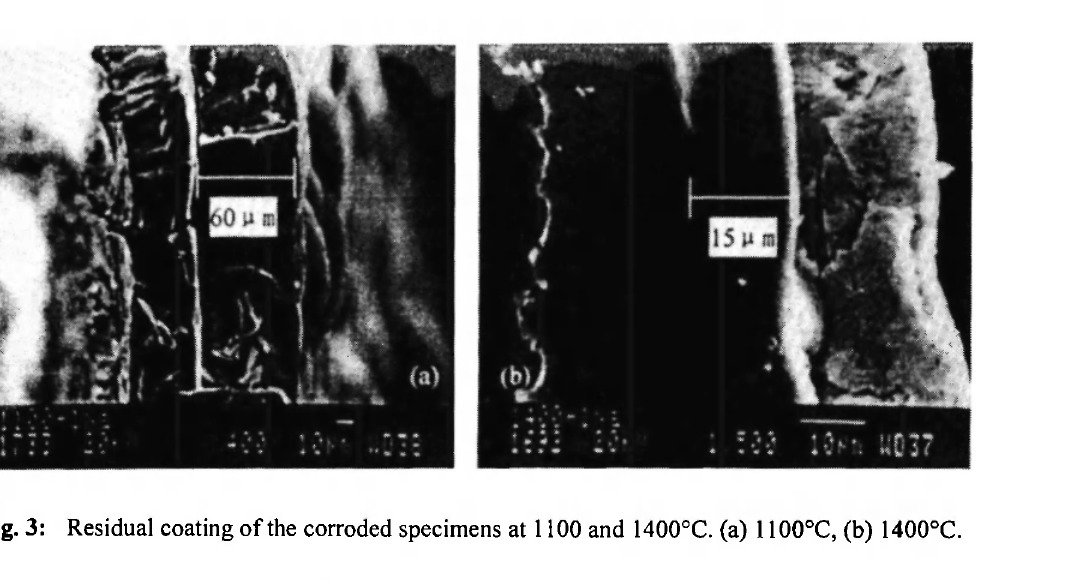
Fig. 4: Relation between weight change and experimental temperatures.